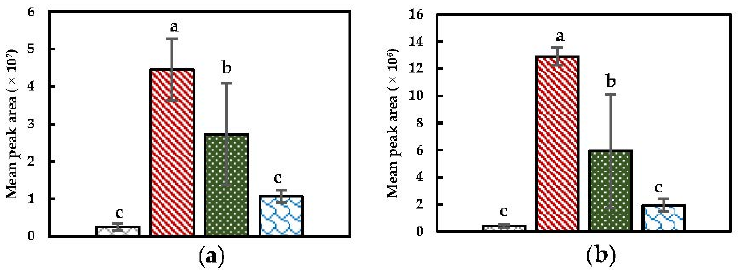
Figure A2. Specific compound plots of selected isothiocyanates in the headspace of differently pre ‐ treated Brussels sprouts (( ) NoPT, ( ) Mix + Heat, ( ) PEF + Heat + Mix, and ( ) Heat + Mix). ( a ) allyl isothiocyanate; ( b ) 4-isothiocyanato-1-butene. Statistically significant differ- ences are designated by different letters ( p < 0.05, n =